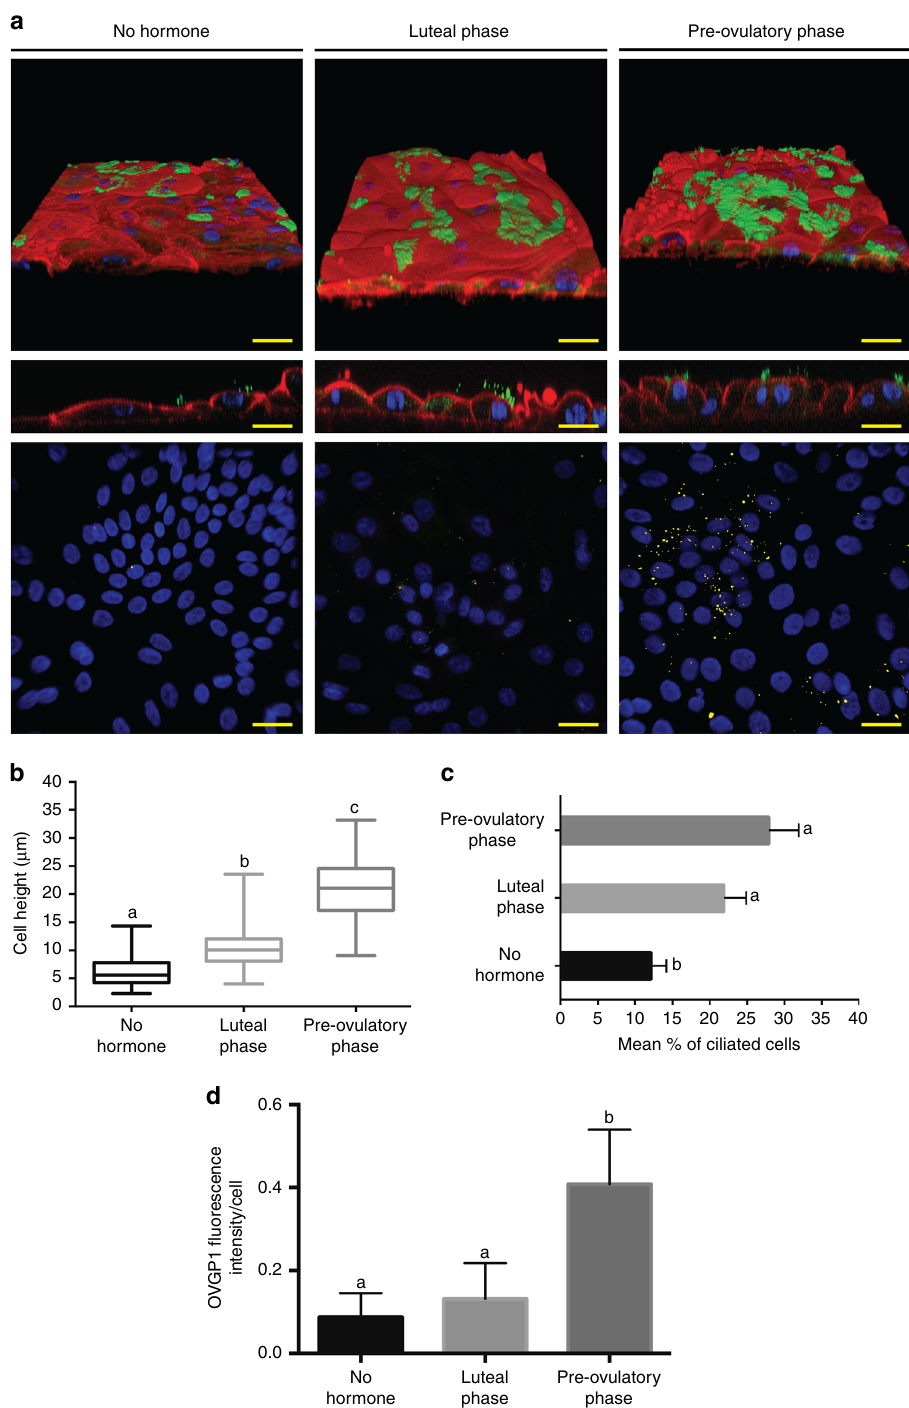
Fig. 3 Effects of hormone stimulation of 3D-cultured BOECs on cell height, ciliation and oviductal glycoprotein 1 (OVGP1) expression under control, and simulated luteal and pre-ovulatory conditions. a Top and middle fi gures: 3D reconstruction of confocal immuno fl uorescent (IF) images for cilia (acetylated alpha-tubulin, green), nuclei (HOECHST 33342, blue), and actin fi laments (phalloidin, red); bottom fi gures: IF for nuclei (blue) and OVGP1 (yellow). b Quanti fi cation of cell height in the different groups ( F = 697.51, p < 0.0001; ANOVA followed by a post-hoc Tukey test). c Average percentage of ciliated cells for each group ( F = 20.415, p = 0.002; ANOVA followed by a post-hoc Tukey test). d Quanti fi cation of OVGP1 expression adjusted for cell number ( F = 12.52, p < 0.0001; ANOVA followed by a post-hoc Tukey test). Graph of b displays average ± s.d and graphs of c and d display average + s.d. Different letters (a vs b vs c in b ; a vs b in c and d ) indicate statistically signi fi cant differences ( n = 6 devices per condition and pool, p < 0.05). Scale bars represent 10 µ